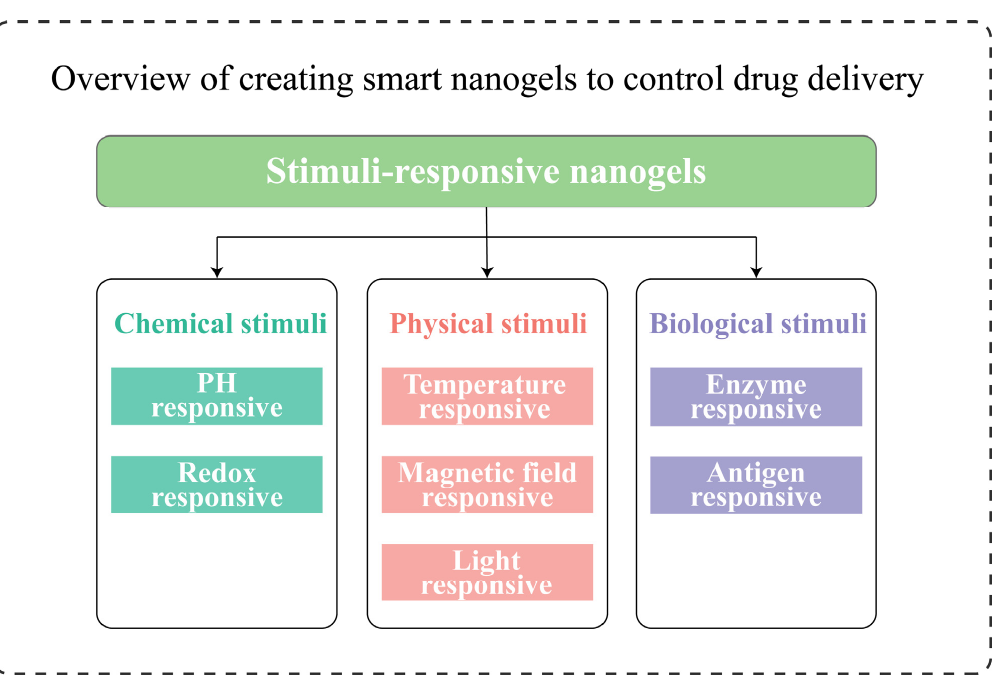
Figure 3. Overview of creating smart nanogels to control drug delivery. According to their response mechanisms, smart nanogels are classified as chemical, physical, or biological stimuli. Synthetic nanogels are chosen to control drug release based on material properties, disease environment, and drug application. However, for the eye, only temperature, pH, and enzyme responses are currently available.